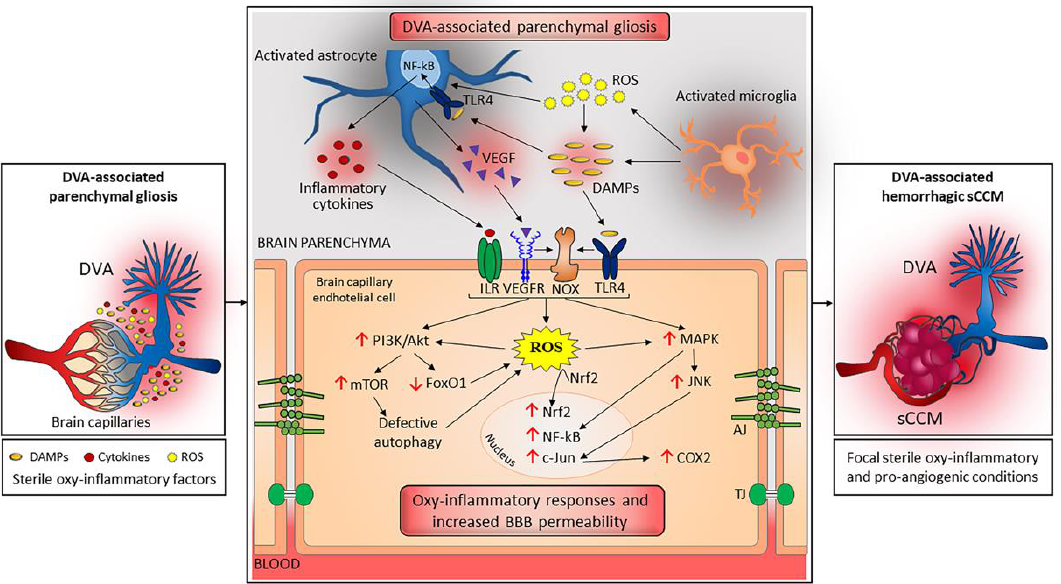
Figure 4. Graphical representation of focal sterile oxy-inflammatory mechanisms potentially impli- cated in the formation and recurrence of a sporadic cerebral cavernous malformation (sCCM) in the drainage territory of a developmental venous anomaly (DVA). Sterile oxy-inflammatory and pro-angiogenic factors, including DAMPs, inflammatory cytokines, ROS, and VEGF, can be released by damaged neurovascular tissues and activated glial cells as a consequence of age-related increased abnormalities in the angioarchitectural and hemodynamic features of a DVA, as well as by other injuries that can contribute to focal gliosis in the adjacent brain parenchyma, such as radiation exposure, neurodegeneration, stroke, and hypoxia. In turn, such factors can induce aberrant oxy-inflammatory signaling pathways in local brain capillary endothelial cells through the activation of multivalent platforms of distinct but interrelated cell surface receptors and enzymes, including interleukin receptors (ILR), VEGF receptors (VEGFR), Toll-like receptors (TLR4), and NADPH oxi- dases (NOX), which eventually result in abnormal oxy-inflammatory and proangiogenic responses, thereby affecting the BBB stability and permeability, and enabling the focal onset of CCM lesions. In particular, these effects are mediated by multiple redox-dependent mechanisms, including NOX-mediated ROS production, upregulation of PI3K/Akt and MAPK signaling, modulation of major redox-sensitive transcription factors, such as FoxO1, NF- κ B, c-Jun, and Nrf2, and mTOR activation-dependent downregulation of autophagy. Eventually, these multiple and interconnected mechanisms lead to abnormal adaptive responses that impair microvessel barrier function and increase their sensitivity to local oxy-inflammatory insults. Notably, these pathological effects can be further facilitated by gain-of-function mutations in genes involved in the PI3K/Akt and MAPK pathways, which have indeed been identified in surgical specimens of sCCM lesions (see Section 3 for further